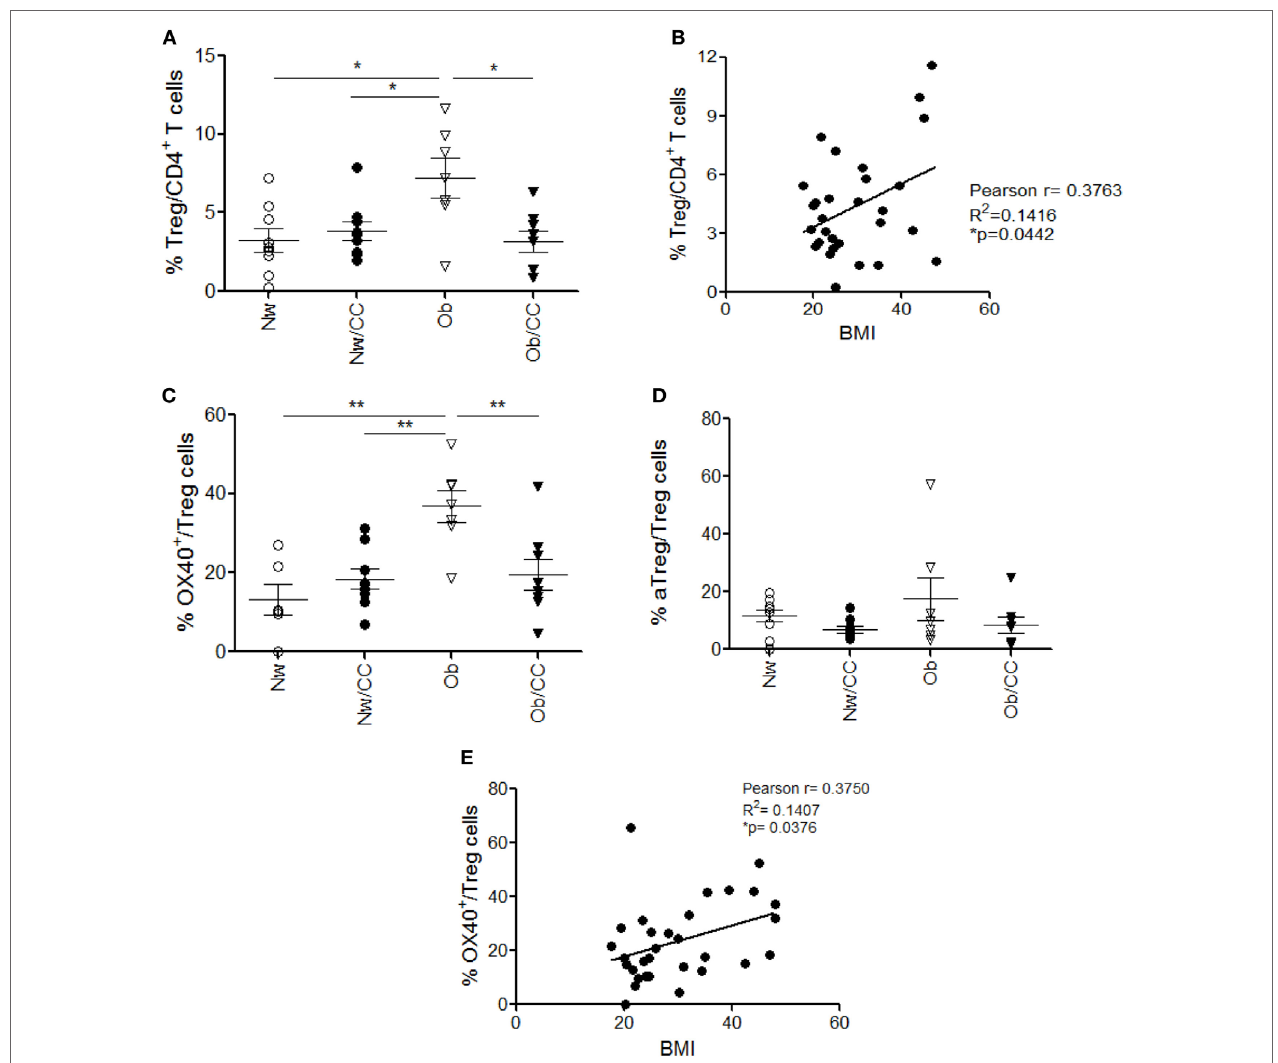
FigUre 3 | A significant increase of total regulatory T (T reg ) cells and a preferential enrichment of OX40 + T reg cells occur in visceral adipose tissue (VAT) stromal vascular fraction (SVF) from obese (Ob) subjects: correlation with body mass index (BMI). VAT SVF lymphocytes isolated from lean normal weight (Nw), Ob, lean affected by colorectal cancer (CRC) (Nw/CC), and Ob affected by CRC (Ob/CC) donors were analyzed by flow cytometry. Frequencies of T reg (CD4 + FOXP3 + CD127 low ) cells (a) , OX40 + T reg cells (c) , and activated T reg cells (CD4 + FOXP3 high CD45RA − ) (D) were estimated in VAT SVF of the four donor groups. Each dot represents an individual donor. Mean ± SEM is shown for each group. * p < 0.05, ** p < 0.01 by analysis of variance. Pearson’s correlation ( r ) between T reg (B) or OX40 + T reg (e) cell frequencies and BMI, in all subjects (* p <